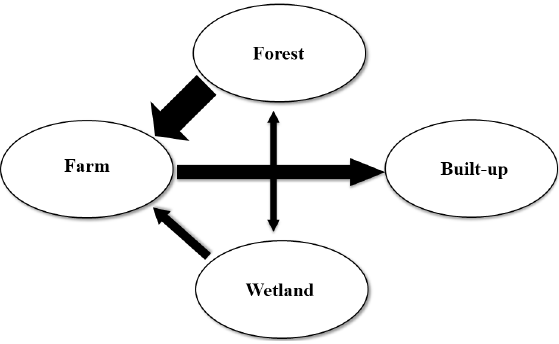
Figure 4. Dominant relationships between the land ‐ use classes.